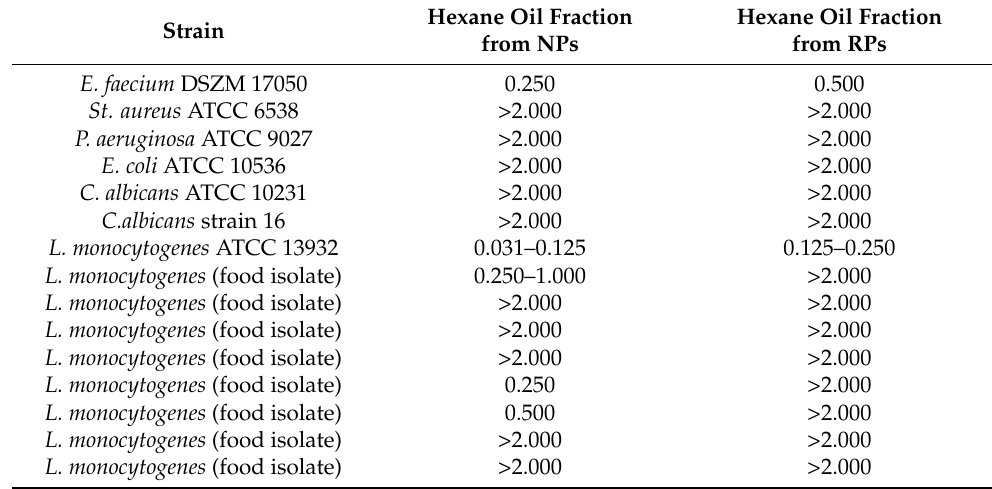
Table 4. MICs of Hexane Pistachio Oil Fractions (expressed as % v / v ) against Gram-positive bacteria, Gram-negative bacteria and yeasts. NP: natural raw pistachios; RP: roasted unsalted pistachios. Hexane Oil Fraction Hexane Oil Fraction Strain from NPs from